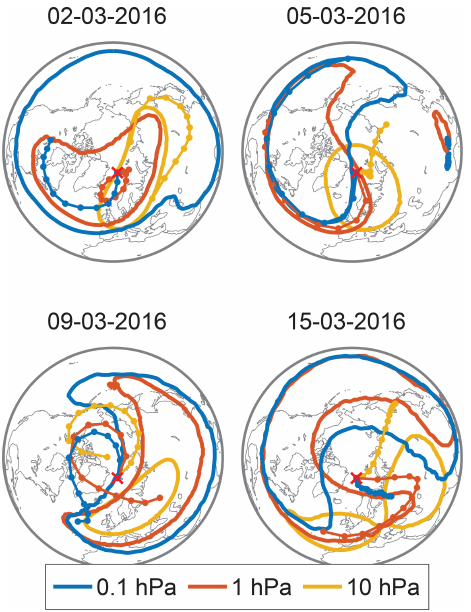
Figure 10. The solid lines indicate the contour of the polar vortex at 10, 1 and 0.1hPa during the major SSW of 2016. The line with dots shows the LAGRANTO 3d backward trajectory at the same altitudes. The red cross indicates the location of Ny-Ålesund.